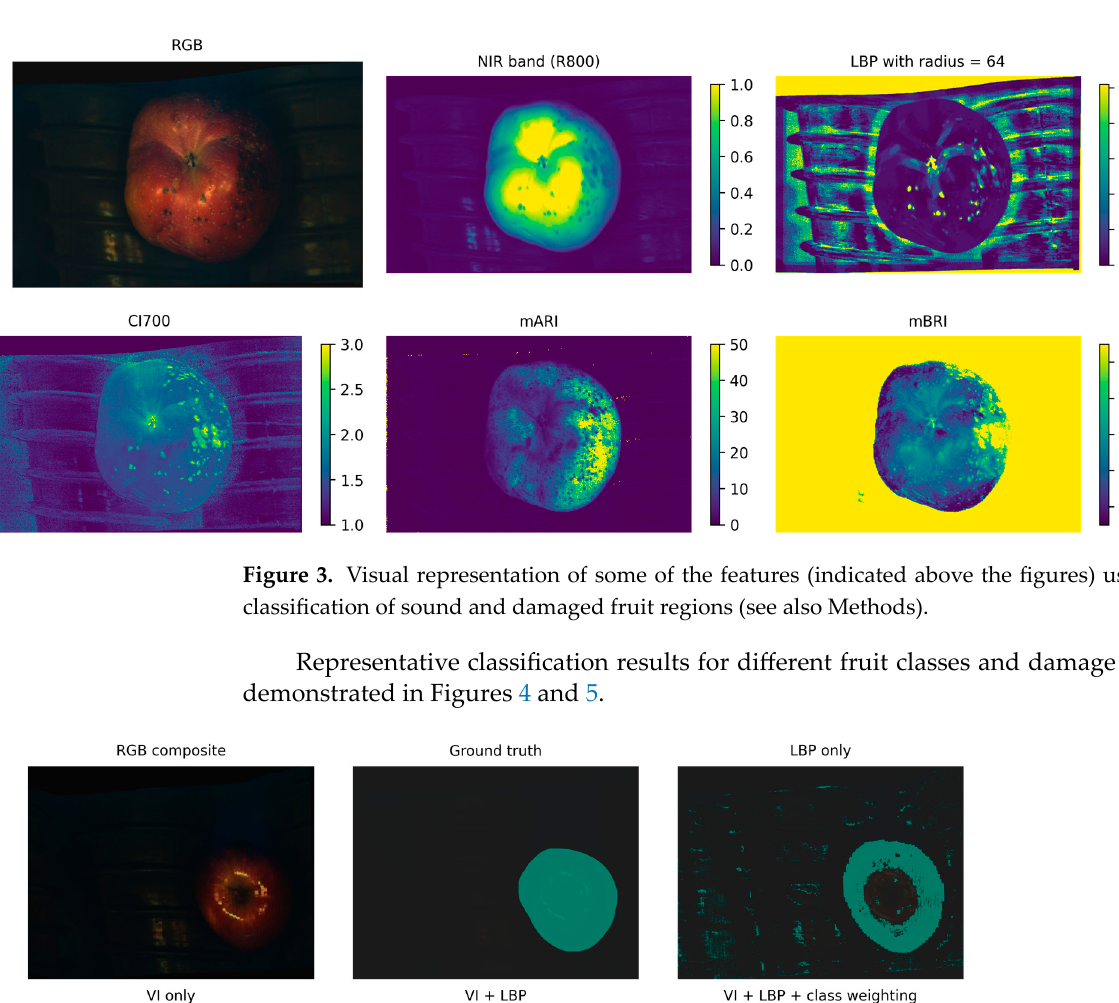
Figure 5. Classification results for an apple with fungal lesions. The texture-only classifier using multiscale LBP turned out to be unusable for dam- age detection in apple fruit, as it has not classified any pixels as damaged tissues in the entire dataset. The inclusion of spectral features was found to be beneficial. Between the spectral classifiers, the difference in results is small, which is particularly remarkable with respect to the spectral downsampling performed. A vegetation indices-based classifier can